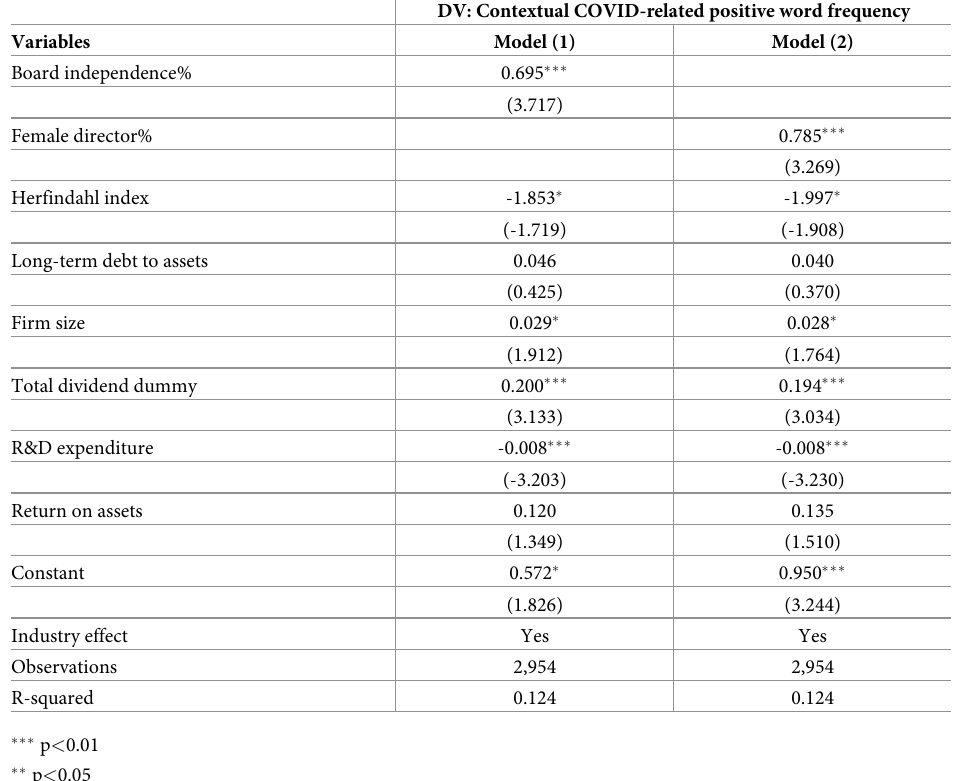
Table 8. Relationship between board-level characteristics and contextual COVID-related positive